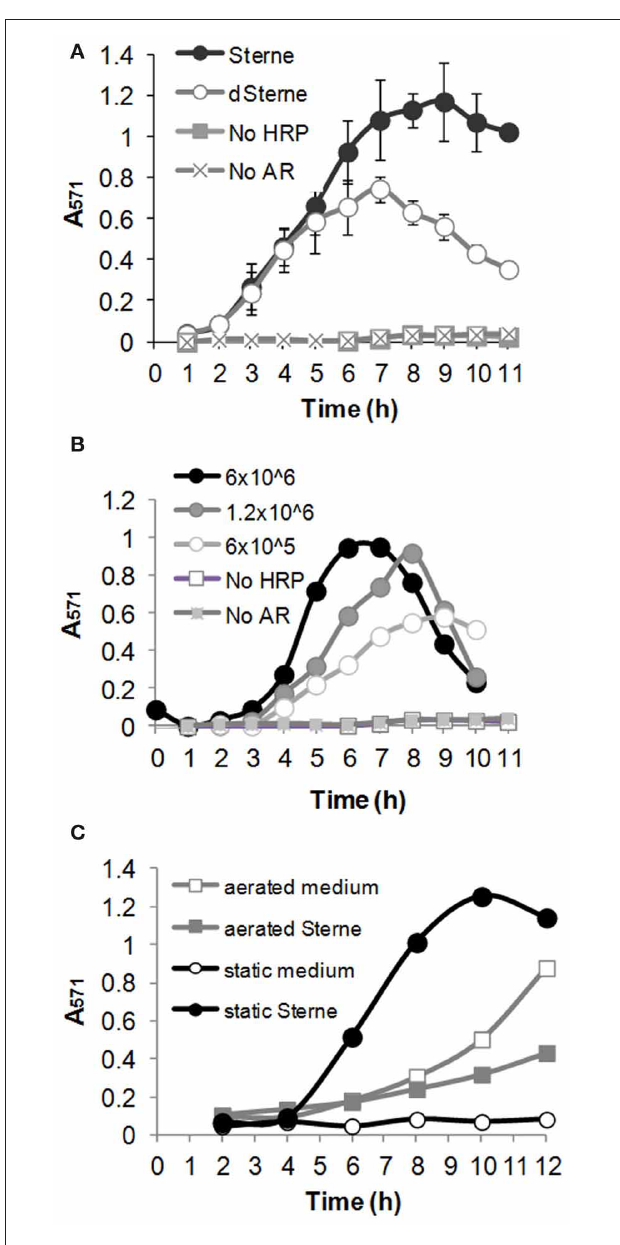
FIGURE 5 | B. anthracis generates oxidizing species in microaerobic cultures. Medium was seeded with spores, and cultures were grown at 37 ◦ C, 5% CO 2 in the presence of 0.2U/ml HRP and 100 μ M Amplex Red (AR). Samples of bacterial suspensions were withdrawn at indicates times. Bacteria were pelleted for 5min and absorbance of Sups was read at 571nm. (A) Comparison of Sterne and dSterne strains. Cultures were seeded into 5ml of CSFM per a well of a 12-well plate at 6 . 0 × 10 6 spores/ml and grown without shaking. (B) Dose dependence of AR oxidation by dSterne strain seeded at the indicated number of spores/ml grown as in (A) . In comparison with (A) , bacterial suspensions in (B) were mixed 1:1 with 1M Tris-HCl, pH 7.4, to correct for the possible effect of pH change on the absorbance of resorufin. (C) Comparison of static and aerated cultures for Sterne strain. Cultures were grown in 6-well plates seeded at 6 . 0 × 10 6 spores/ml. For aeration the plates were shaken at 200rpm. Error bars indicate standard deviations ( n =